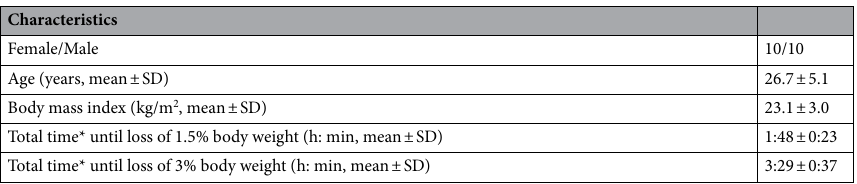
Table 1. Baseline characteristics of study participants. * Total time refers to the total time needed to reach the respective dehydration, including both sauna and cooling down